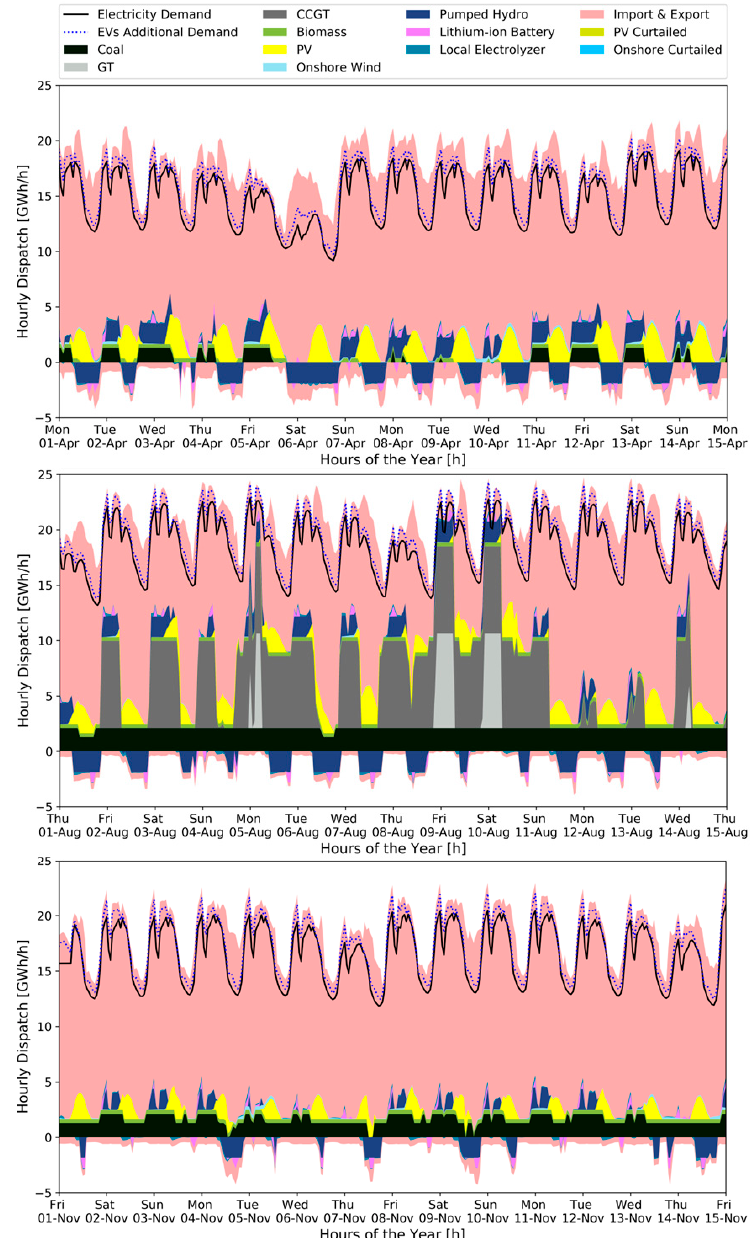
Figure 13. Typical hourly generation by technology, export and charge ( − ), import & discharge ( + ) to meet Beijing’s power demand of April, August and November 2030.